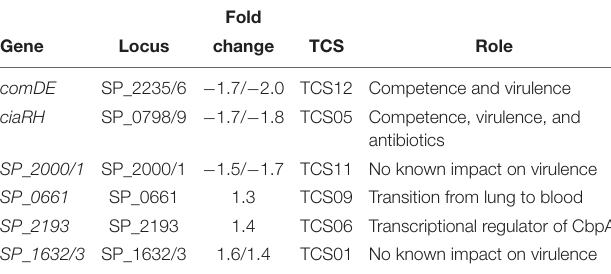
TABLE 4 | Differentially expressed two component system genes in (cid:49) cadA